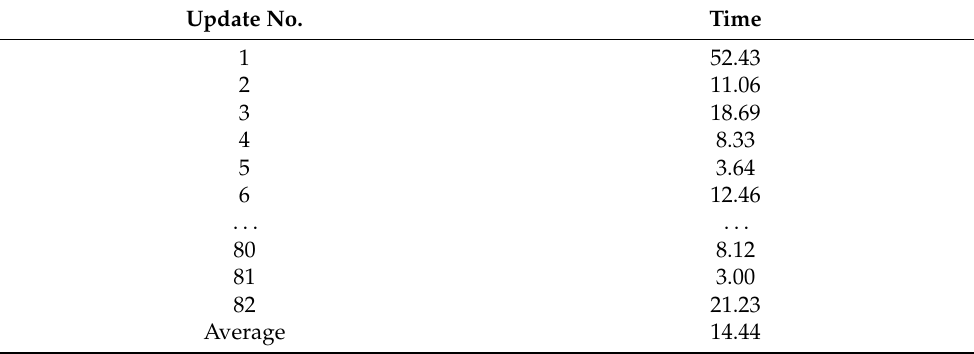
Table 2. Calculation time of each model